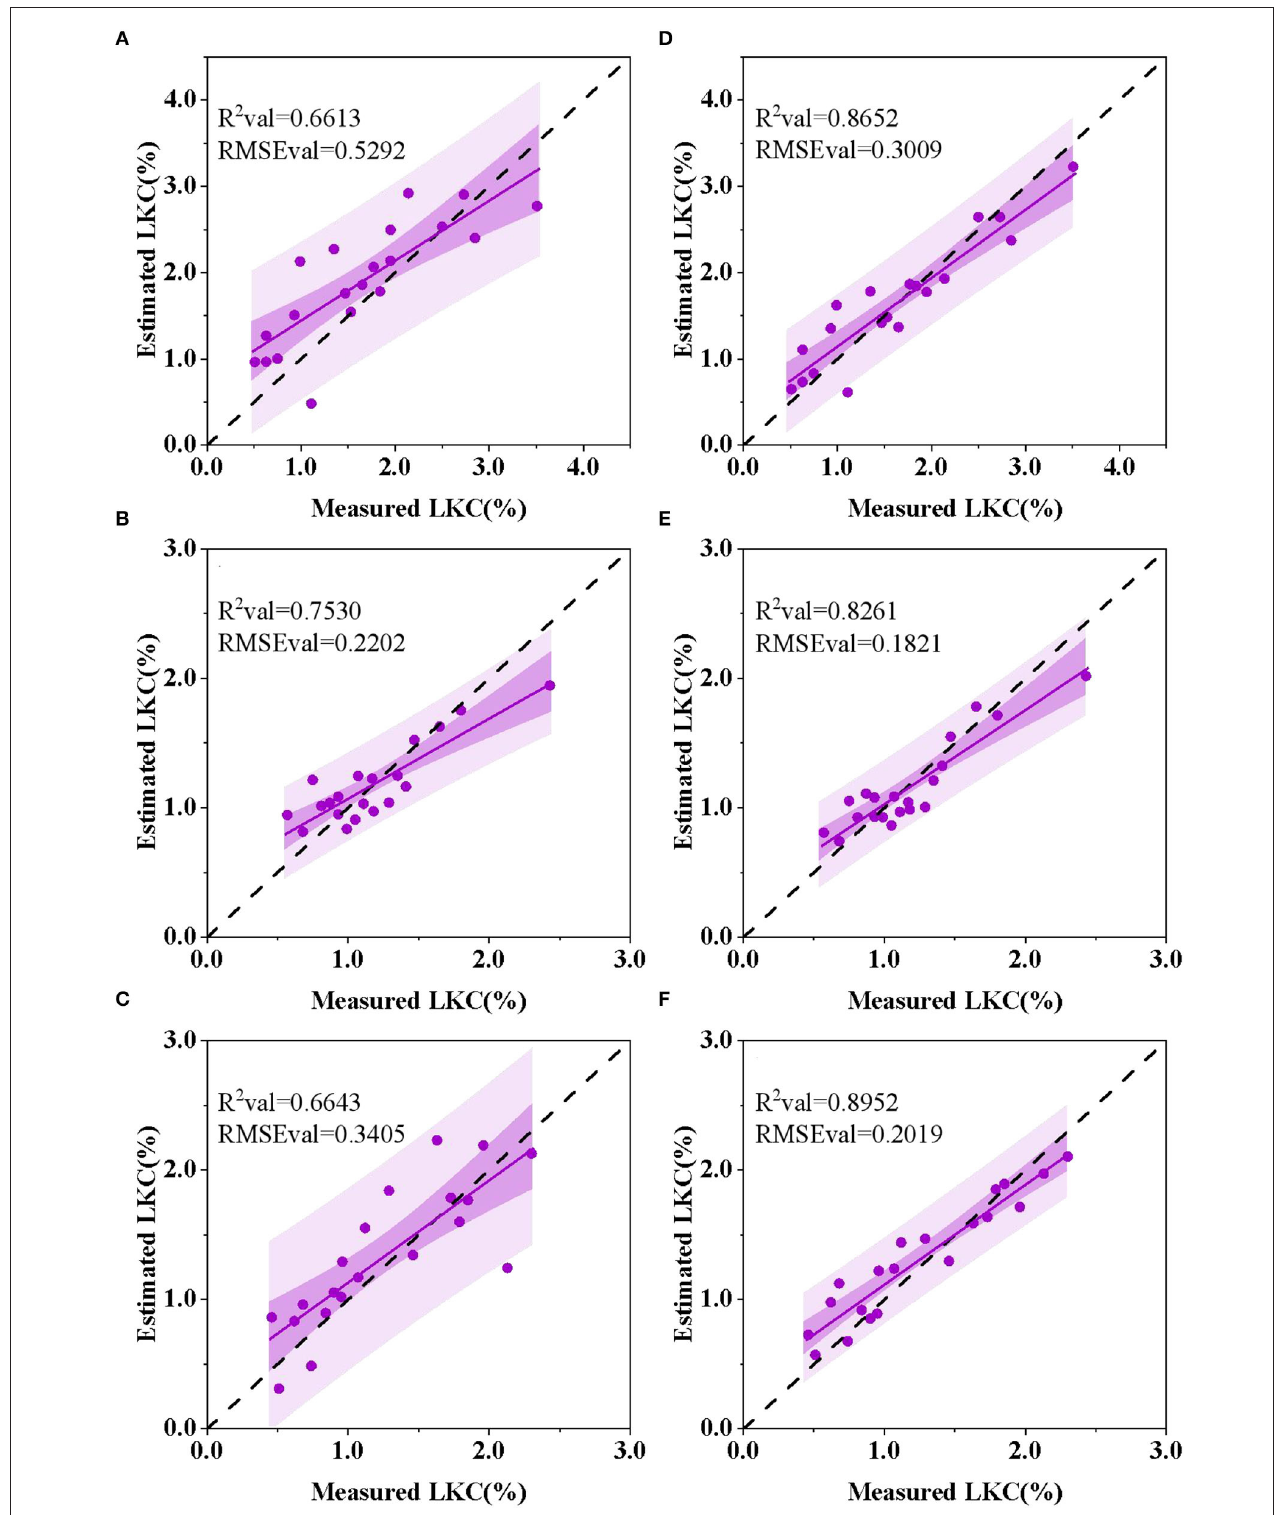
FIGURE 10 | Optimal PLSR estimation model of the LKC in cotton at different growth stages. (A) Budding stage, R spectrum. (B) Flowering stage, R spectrum. (C) Boll setting stage, R spectrum. (D) Budding stage, CWT-1